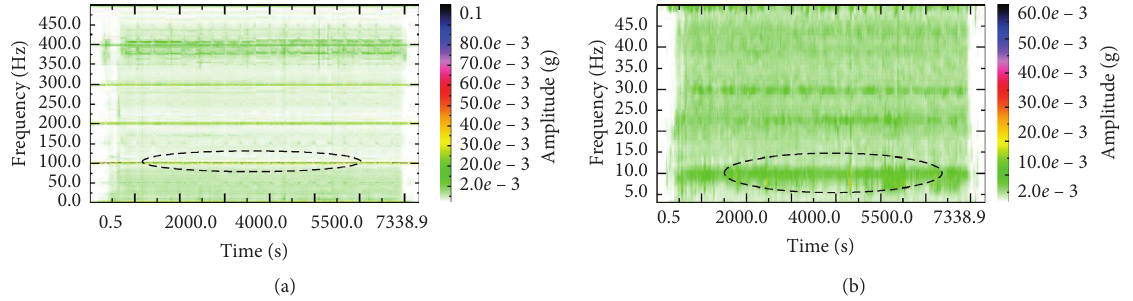
Figure 14: Spectrum of vertical acceleration on CBSE traction transformer: (a) zoomed; (b) enlarged.